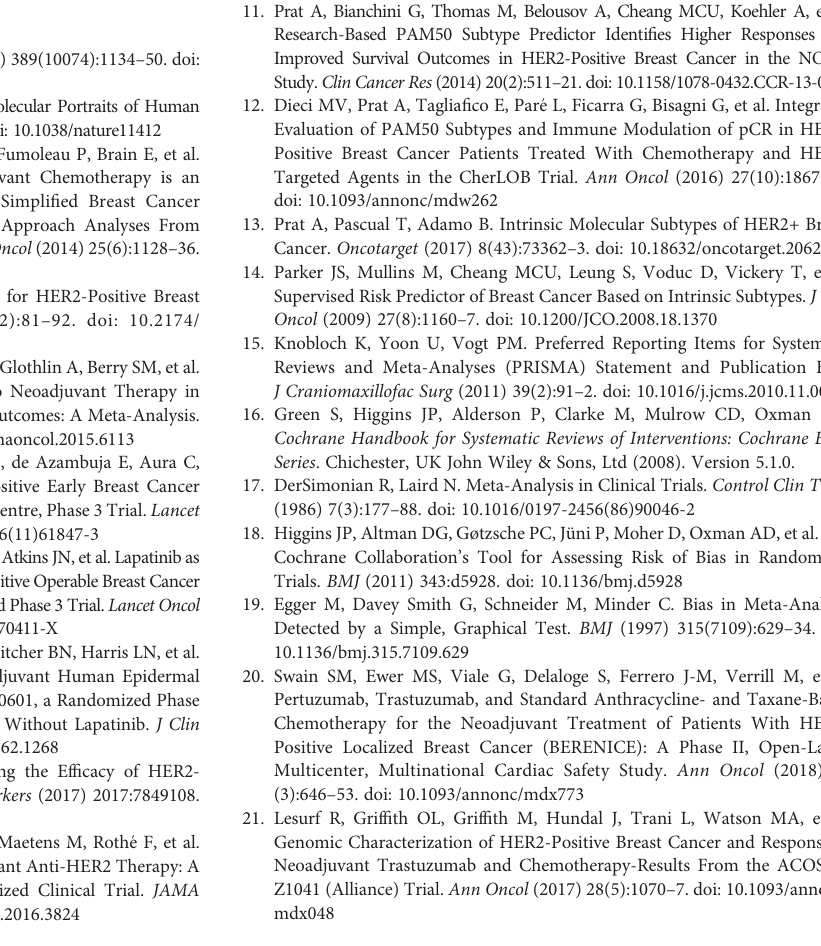
Supplementary Figure 1 | Flow chart for the selection process of eligible publications. Supplementary Figure 2 | Forrest plot of odds ratio (OR) used to evaluate the correlations between intrinsic molecular subtype subgroups (HER2-enriched vs. non-HER2-enriched) and pCR as based on trastuzumab only- or lapatinib only- based chemotherapy. CI, con fi dence interval; HER2, human epithelial growthfactor receptor 2; pCR, pathological complete response. Supplementary Figure 3 | Forrest plot of odds ratio (OR) used to evaluate the correlations between intrinsic molecular subtype subgroups (HER2-enriched vs. non-HER2-enriched) and pCR in overall patients excluding non-randomized studies. CI, con fi dence interval; HER2, human epithelial growth factor receptor 2; pCR, pathological complete